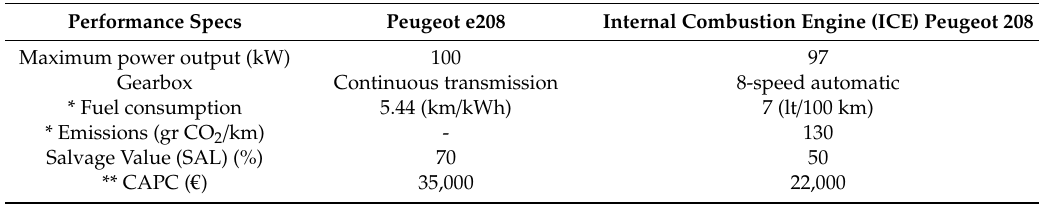
Table 2. Vehicle specifications and